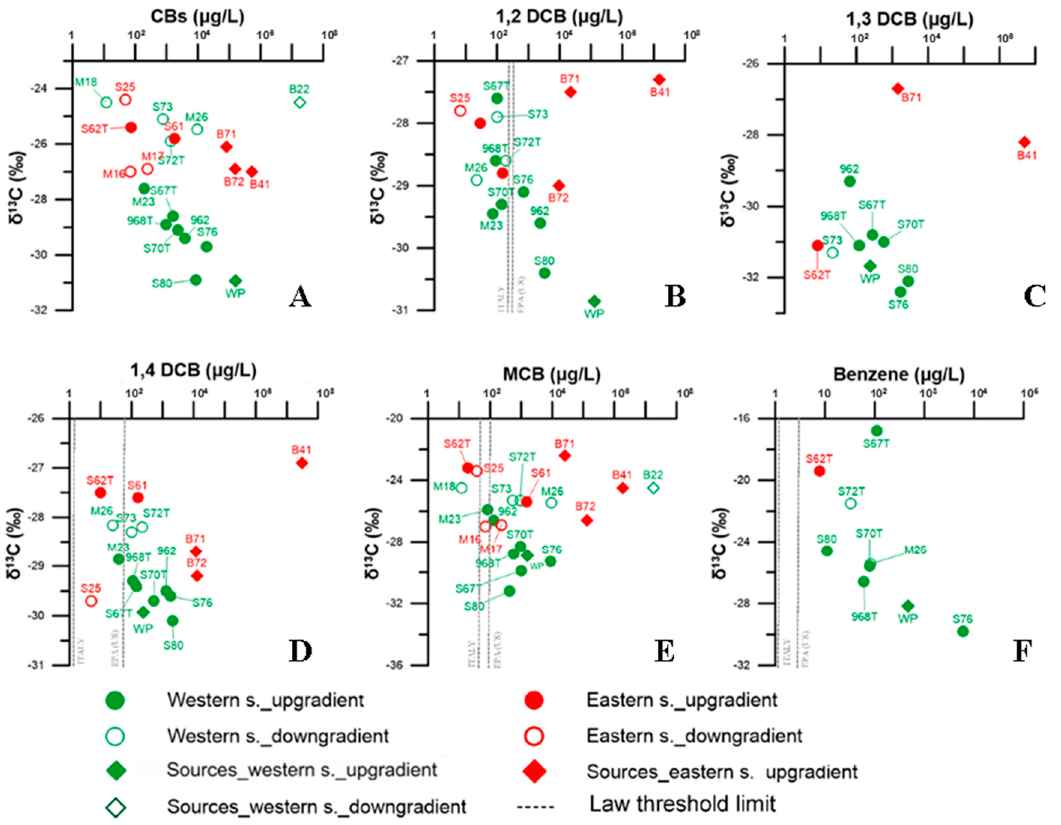
Figure 3. Scatterplots of concentration versus δ 13 C of total chlorobenzenes (CBs) ( A ), 1,2-dichlorobenzene (DCB) ( B ), 1,3-DCB ( C ), 1,4-DCB ( D ), MCB ( E ) and benzene ( F ). Green and red circles refer to wells located in the western and eastern sectors, respectively; green and red rhombuses refer to the sources, soil samples (B-) and processing waters (WP). Concentrations are expressed in µ g L − 1 and µ g kg − 1 for groundwater and soil samples, respectively. Empty and filled symbols refer to the downgradient and upgradient of the hydraulic barrier, respectively. Data are shown in Table 1. See Figure 2 for sample locations.